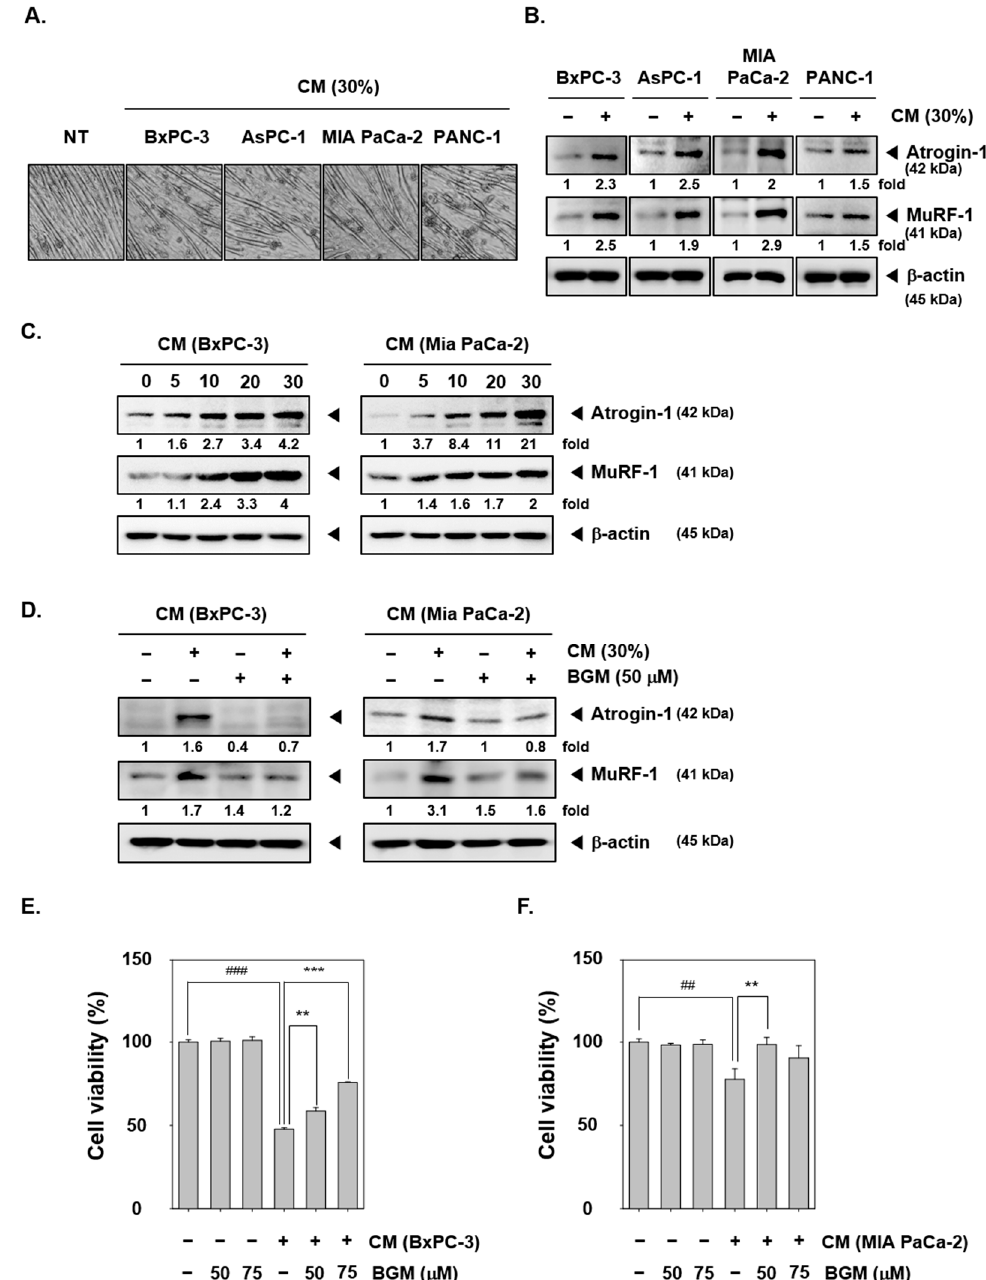
Figure 1. Suppressive effects of bergamotiin (BGM) upon cancer cachexia-induced muscle cells atrophy. C2C12 cells were stimulated with CT26 cells conditioned media (CM) for 3 days. ( A ) C2C12 cells induced cancer cachexia by incubation with various cancer cells CM for 24 h and morphological changes were observed. ( B ) C2C12 cells were incubated with 30% CM for 24 h, which were obtained from BxPC-3, AsPC-1, MIA PaCa-2, and PANC-1 cells. Then, the expression levels of E3 ubiquitin ligases Atrogin-1 and MuRF-1 were observed by Western blot analysis. ( C ) C2C12 cells were incubated with various concentrations of CM and evaluated by Western blot analysis. ( D ) C2C12 cells were treated by BGM (50 µM) with BxPc-3 and MIA PaCa-2 cells 30% CM for 24 h. Thereafter, Atrogin-1 and MuRF-1 expression levels were analyzed by Western bolt analysis. ( E,F ) C2C12 cells were treated with BGM (0, 50, and 75 µM) with BxPc-3 and MIA PaCa-2 cells 30% CM for 48 h. Then, the cell viability was measured by the 3-(4,5-dimethylthiazol-2-yl)-2,5-diphenyltetrazolium bromide (MTT) assay. All the experiments were performed independently at least 3 times, and representative data are shown. Data represent means ± SD. ## p < 0.01 vs. NT, ### p < 0.001 vs. NT, ** p < 0.01 vs. BGM, *** p < 0.001 vs. BGM.